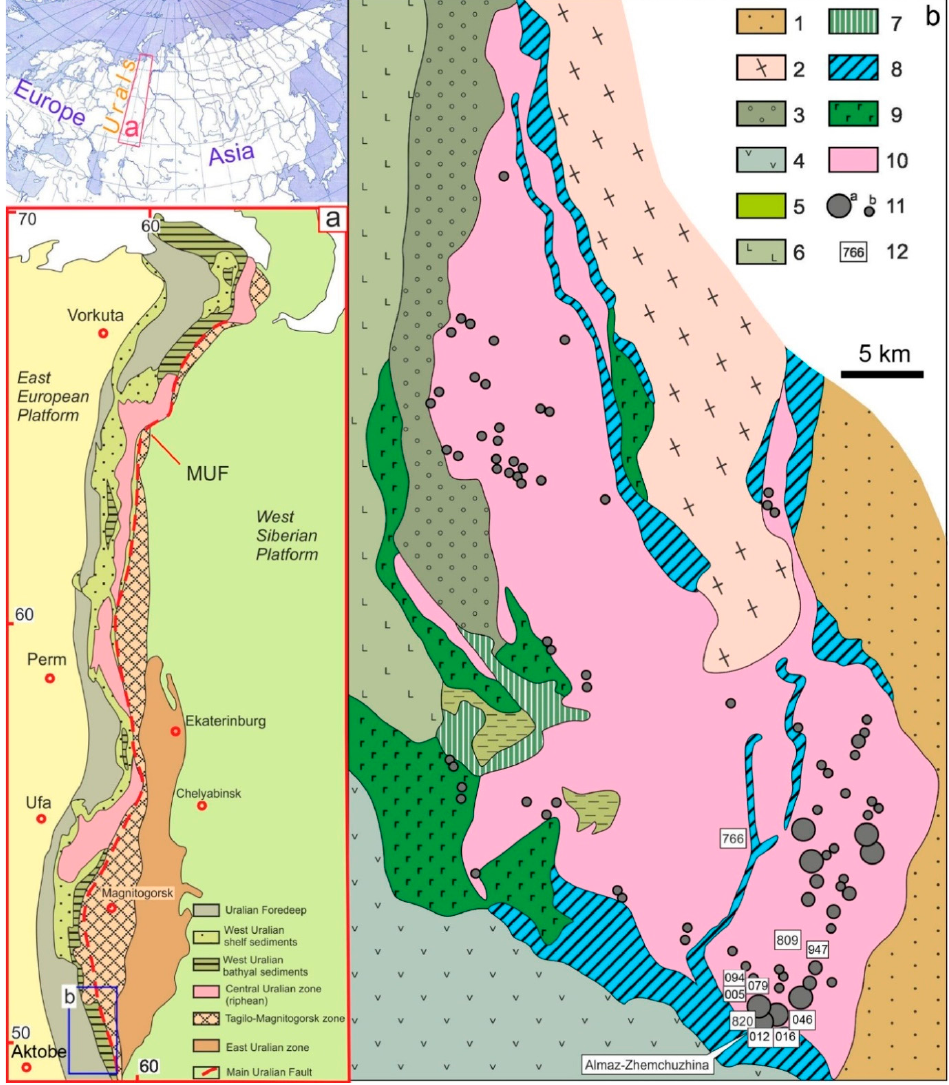
Figure 1. ( a ) Position of the Kempirsay ophiolite massif within Uralian fold belt (after [32]) and its schematic geological map (after [15,24]) ( b ): 1–6—Stratified rocks: 1—Yuzhnomugodzhary zone (basalts (S-D 1 , D 2 ), flyschoids and olistostromes (D 3 -C 1 ); 2—Ebeta zone (basalt-andesite-rhyodacite units, carbonaceous-silicite and greywacke formations (V?PZ 1–2 ); 3–6—Sakmara zone: 3—basalt-andesite-dacite units, greywacke phthanite and carbonate formations (PZ 1–2 ), 4—pillow lavas and pyroclastics of basalt-andesite-rhyodacite units with members of phtanites and clay-siliceous shales (PZ 1–2 ), 5—phtanites and carbonaceous shales (O 2 ), 6—tholeiite pillow basalts with phtanite lenses (O 2 ), 7–10—Kempirsay massif: 7—swarms of parallel diabase dykes and iso-